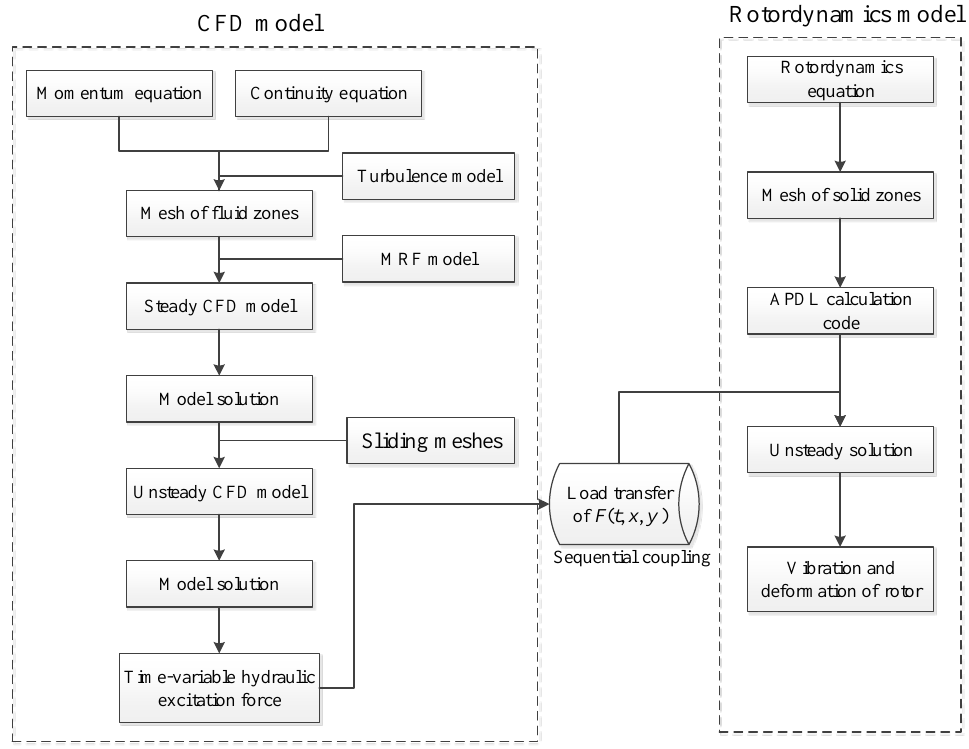
Figure 1. Overall framework of the coupling model.